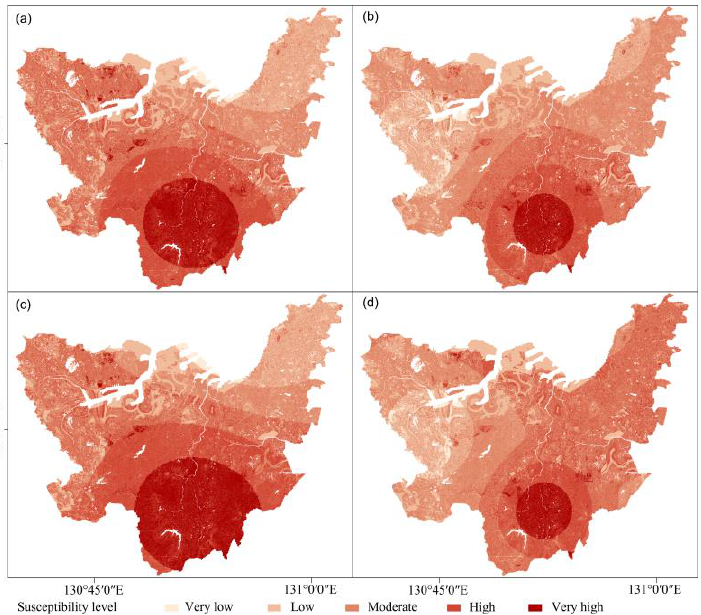
Figure 11. Spatiotemporal LSMs of ( a ) development stage; ( b ) peak stage; ( c ) stagnation stage; and ( d ) decline stage.